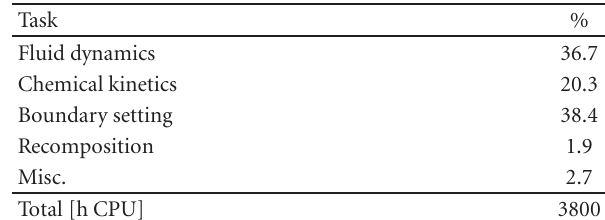
Table 2: Breakdown of the computational time for the first three- dimensional rectangular structure simulation.